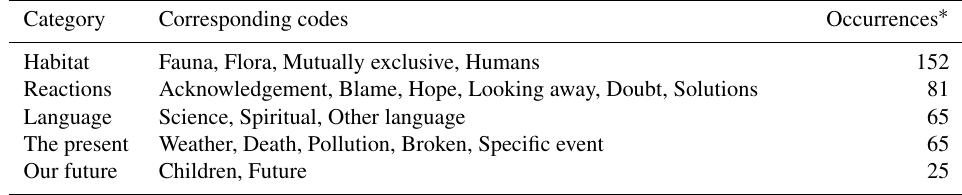
Table 2. The categories that emerged, alongside their corresponding codes. Category Corresponding codes Occurrences ∗ Habitat Fauna, Flora, Mutually exclusive, Humans 152 Reactions Acknowledgement, Blame, Hope, Looking away, Doubt, Solutions 81 Language Science, Spiritual, Other language 65 The present Weather, Death, Pollution, Broken, Specific event 65 Our future Children, Future